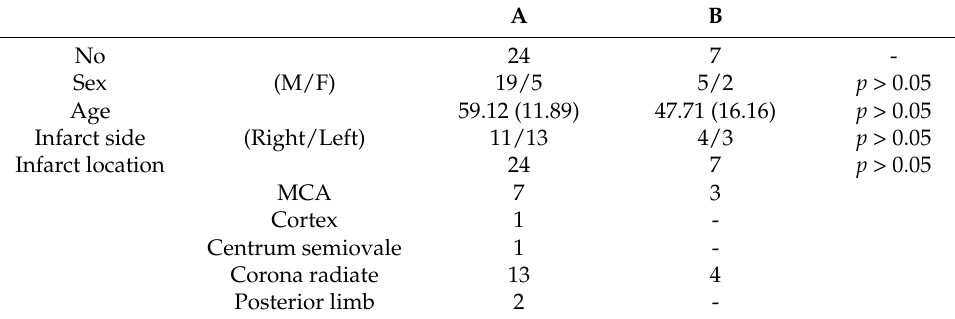
Table 1. Demographic data in groups A and